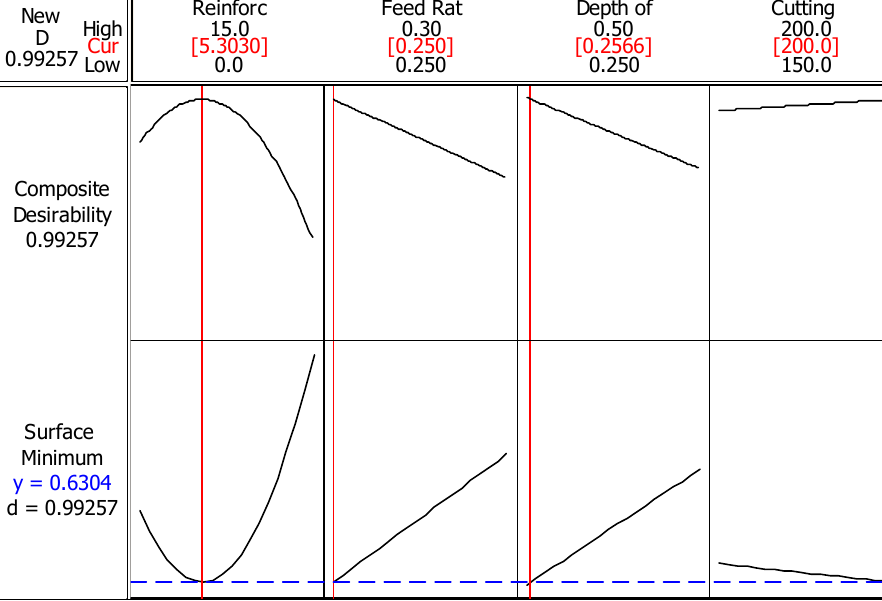
Figure 4. RSM (response surface methodology) optimization of surface roughness.